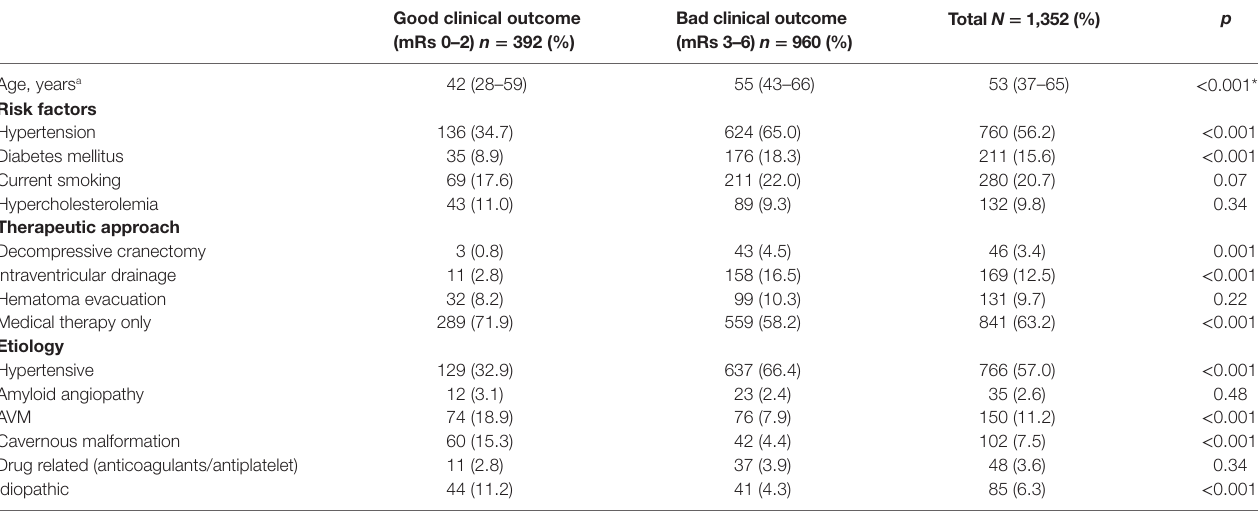
TaBle 2 | General features and vascular risk factors according to clinical outcome at discharge modified Rankin scale (mRs) in patients with intracerebral hemorrhage.